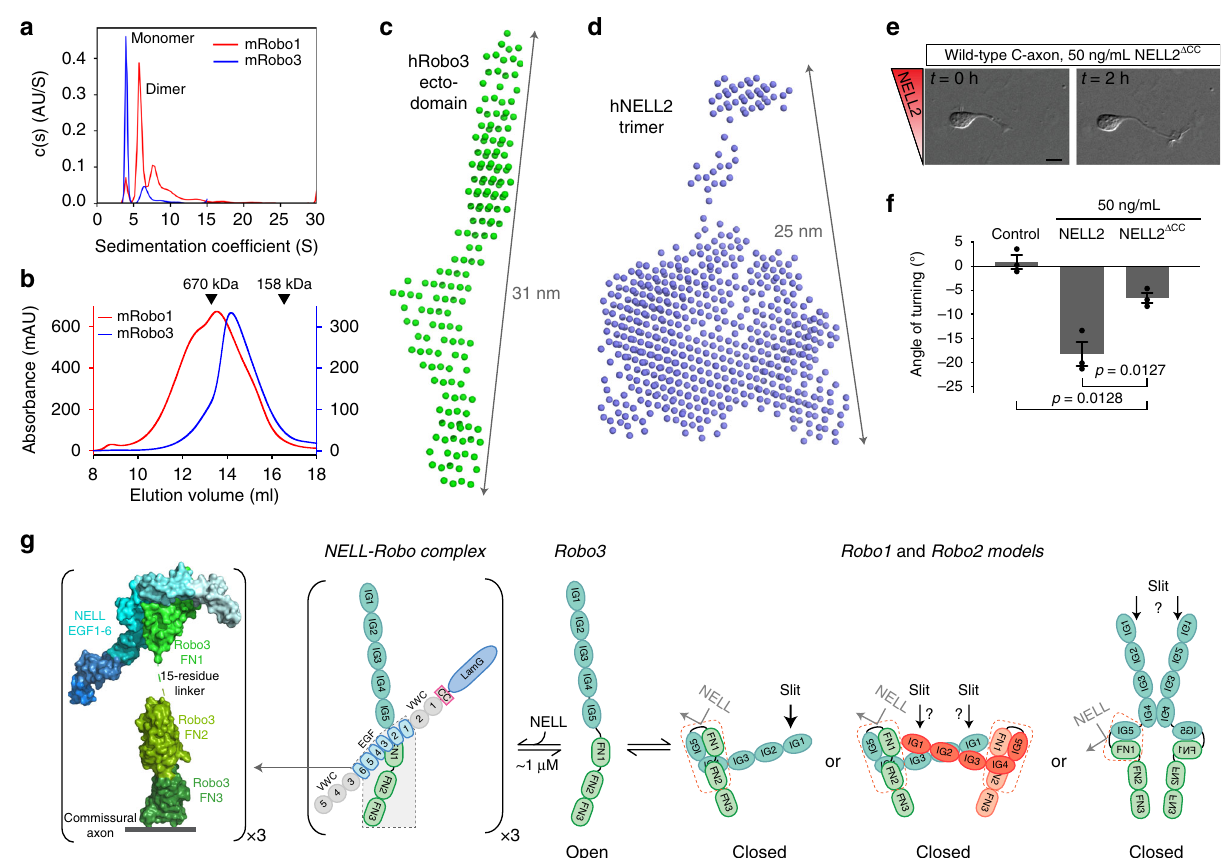
Fig. 7 NELL2 trimers signal through multimerization of Robo3 monomers. Sedimentation velocity (SV) AUC ( a ) and SEC ( b ) show that mRobo1 ectodomain is mostly dimeric (red curves), while mRobo3 ectodomain is a monomer (blue curves). Single-concentration SV runs ( a ) were performed with 2.5 µ M Robo1 and 1.8 µ M Robo3. See Supplementary Fig. 7 for a series of concentrations, which shows that mRobo1 ectodomain is in an equilibrium of monomer to dimer to oligomer, unlike the stably monomeric mRobo3. c Bead models calculated from SAXS data indicate a fully extended shape for hRobo3 ECD. Guinier plot for SAXS data is in Supplementary Fig. 8a. Pair distance distribution ( P ( r )) analysis is in agreement with the extended shape of Robo3. d Bead models calculated from SAXS data for hNELL2 indicate a trimer more compact than Robo3 ECD ( c ). Guinier plot analysis and P ( r ) plot are in Supplementary Fig. 9a. e DIC images of commissural axons exposed to wild-type NELL2 or NELL2 Δ CC (0 and 2 h). f Quanti fi cation of axon turning angles in response to NELL2 and NELL2 Δ CC ( n = 3 for all conditions). NELL2 Δ CC repels axons to a lesser degree than wild-type NELL2. g A model for conformational changes in mammalian Robos. Open Robo3 prefers to bind trimeric NELLs, while multiple conformational models exist for Robo1 and Robo2 16,17 , which are in “ closed ” states for NELL binding. The conformational fl exibility is created by the IG4-IG5, IG5-FN1, and FN1-FN2 linkers. The lightly shaded area in the NELL – Robo complex model was structurally characterized in this study (shown on the left side of the model). “ x3 ” labels indicate trimerization via the CC domain of NELLs. Scale bar, 10 μ m ( e